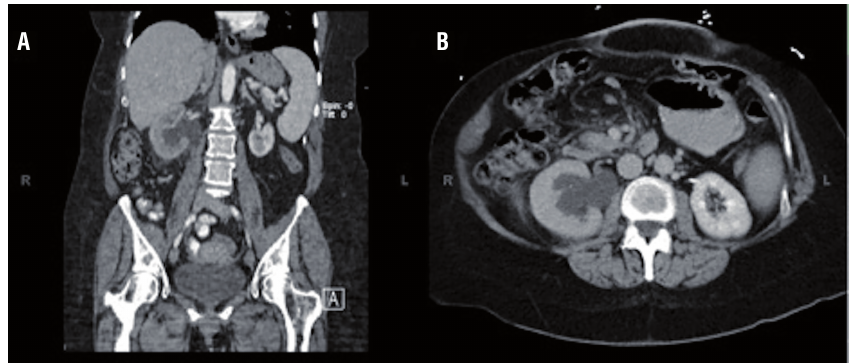
Figure 1 - Coronal (a) and axial (b) contrast-enhanced computed tomography revealed moderate-to-severe right hydronephrosis with decreased nephrogram of the right kidney, concerning for high-grade right UPJ